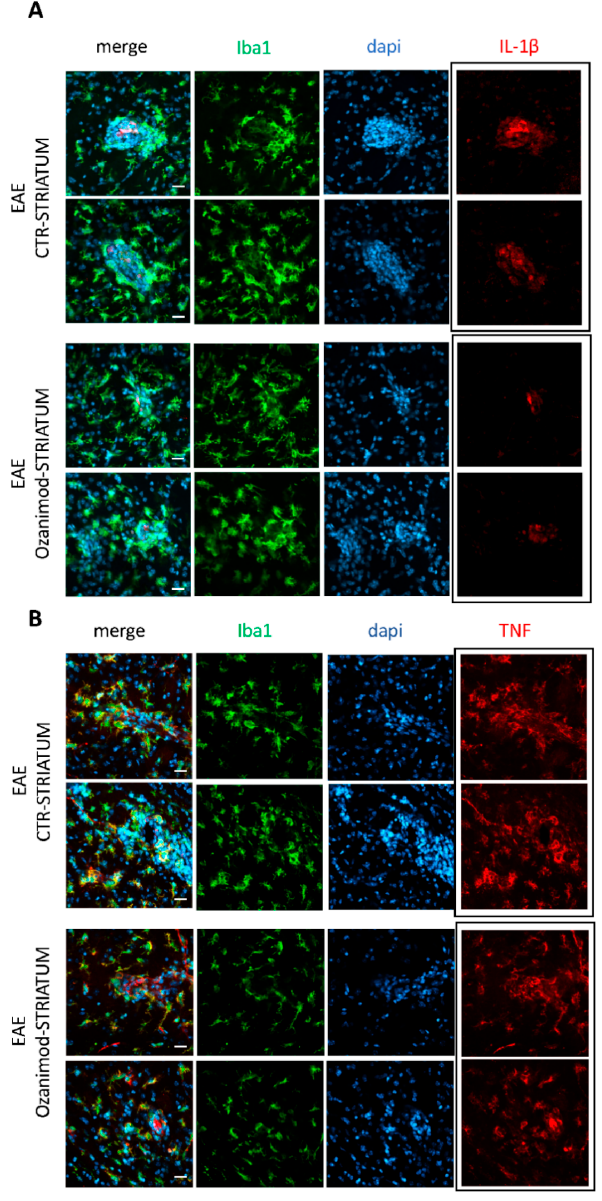
Figure 3. Ozanimod attenuates IL-1 β immunolabelling with negligible effect on TNF in EAE striatal slices. Confocal images of EAE striatal slices incubated with vehicle or ozanimod (1000 nM, 2 h) stained for IBA1 (green), cell nuclei (cyan), IL-1 β (red in A ), and TNF (red in B ) show that ozanimod treatment leads to a significantly milder expression of IL-1 β within lesioned area, highlighted by IBA1 and dapi staining, with minor effect on TNF. Scale bars: 20 μ m.